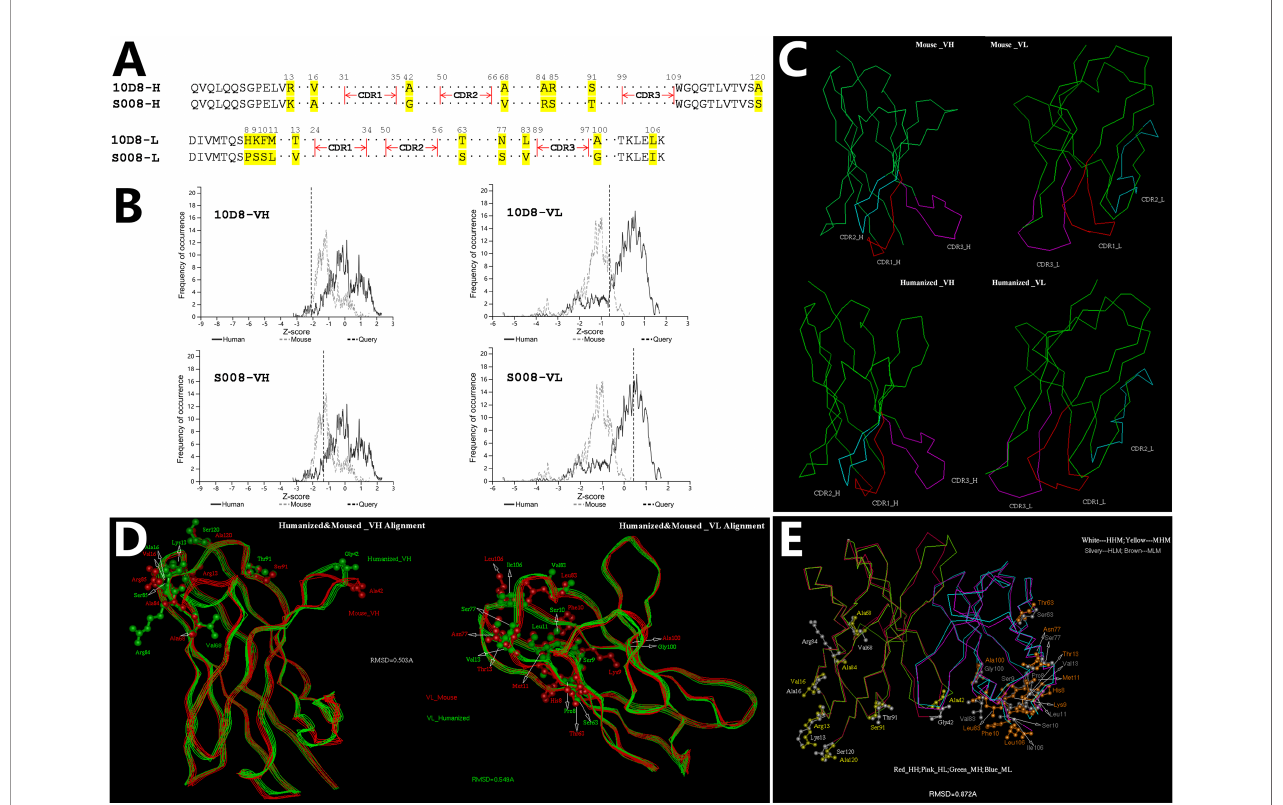
FIGURE 1 | Computer-aided humanization of mouse anti-abrin antibody. (A) Amino acid alignment of variable domains between humanized antibody S008 and parent murine anti-body 10D8. (B) Humanness degree analysis of variable domain of heavy chain (left) and light chain (right) of 10D8 (upper) and S008 (lower) using http://www.abysis.org. The location of the dotted lines indicates the Z scores. (C) Modelled structures of the variable domains of S008 and 10D8 and superimposition of antibody chains; ( C , Upper left) VH structure of 10D8; ( C , Upper right) VL structure of 10D8; ( C , lower left) VH structure of S008; ( C , lower right) VL structure of S008. (D) Superimposition of heavy chain (left) and light chain variable domains (right). (E) Superimposition of variable domain of S008 and